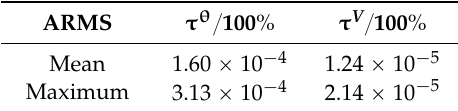
Table 4. Mean and maximum of ARMS of order-3 SG-PLF